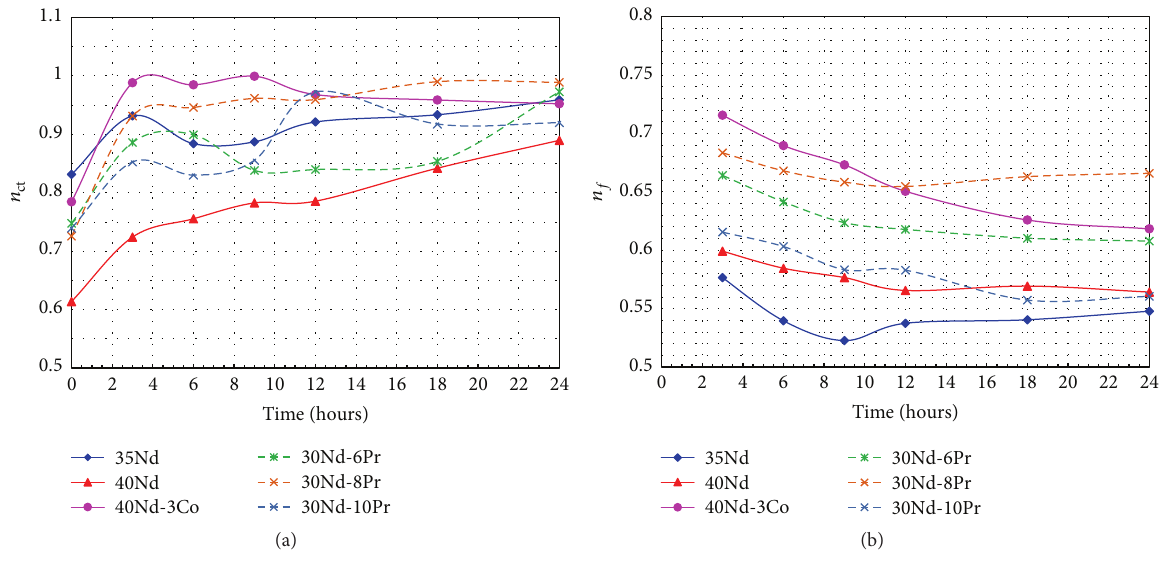
Figure 20: 𝑛 ct and 𝑛 𝑓 variation against time for the tested magnets.